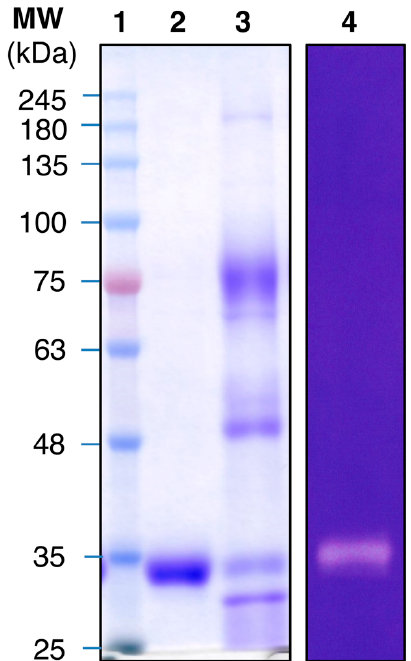
Figure 2. Molecular mass determination of purified protease from B. megaterium -TK1. SDS-PAGE analyses (lanes 1–3, stained with Coomassie Brilliant Blue R-250 (CBB R-250)) of isolated protease. Lane 1: pre-stained protein MW markers, lane 2: purified protease from Sephadex G-100 column chromatography (MW ~33 kDa), lane 3: partially purified protease from DEAE-C column chromatography. Zymography (lane 4) of purified protease on native-PAGE using 0.1% BSA as the substrate and stained with 0.1% ( w / v ) CBB R-250 (MW ~33 kDa). Table 1. Overview of B. megaterium -TK1-derived protease purification steps and yields.